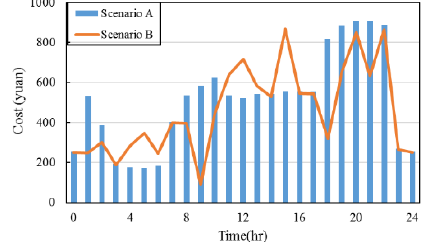
Fig. 5. Comparison of typical daily operating